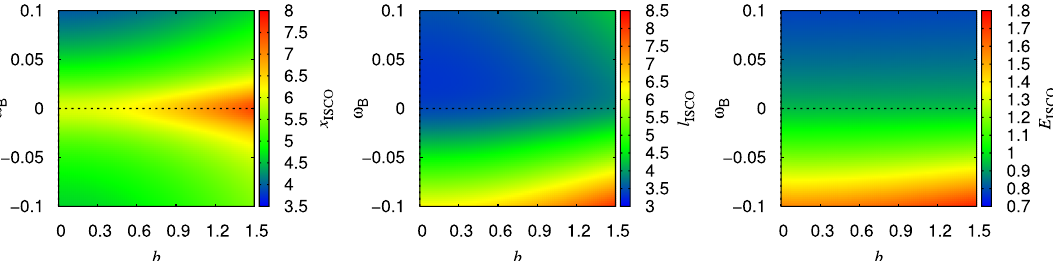
Fig. 7 x ISCO (left), l ISCO (middle) and E ISCO (right) of charged test particles around quantum-corrected Schwarzschild black holes immersed in an external asymptotically uniform magnetic field with